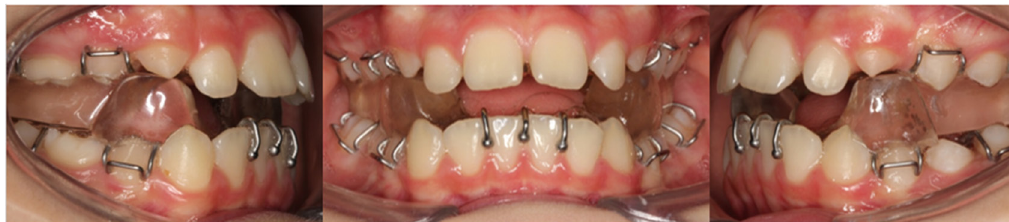
Figure 2. The modified Clark’s Twin Block appliance.